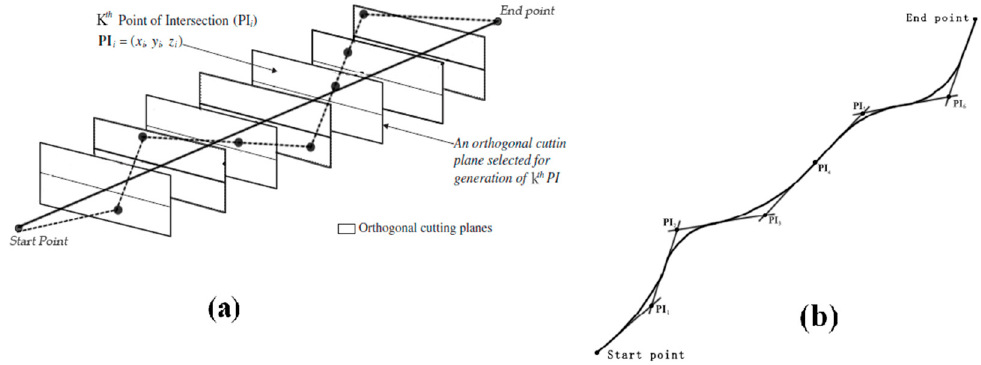
Figure 8. ( a ) A series of PIs; ( b ) geometric specification of typical horizontal alignment.